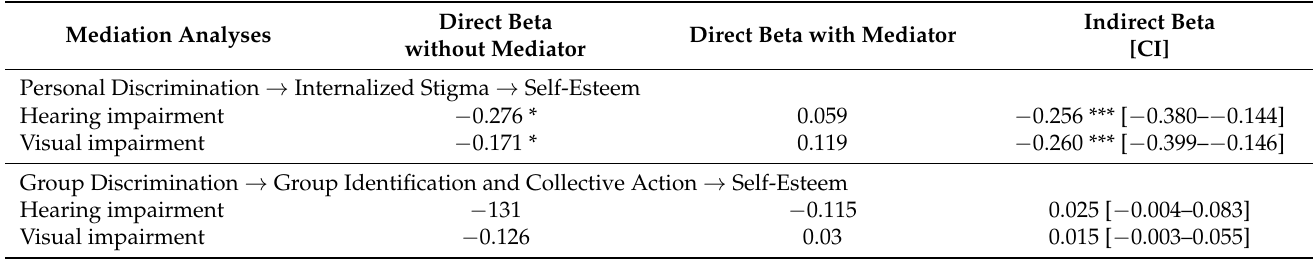
Table 3. Results of mediation analysis.